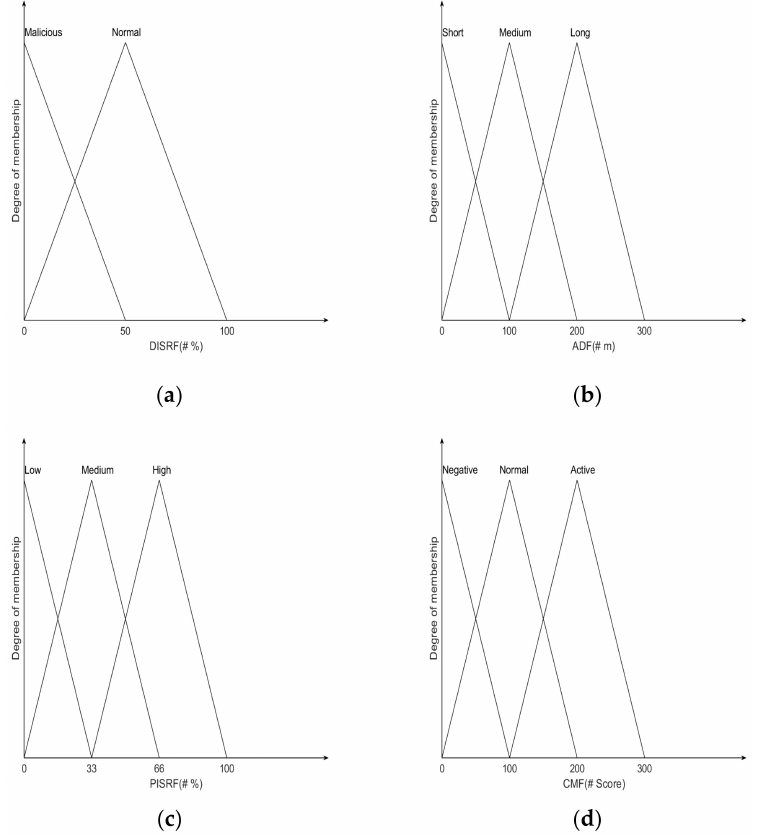
Figure 3. The input membership function of LFCTEM: ( a ) direct interaction success rate factor; ( b ) adjacent distance factor; ( c ) public interaction success rate factor; ( d ) cooperative incentive mechanism factor.